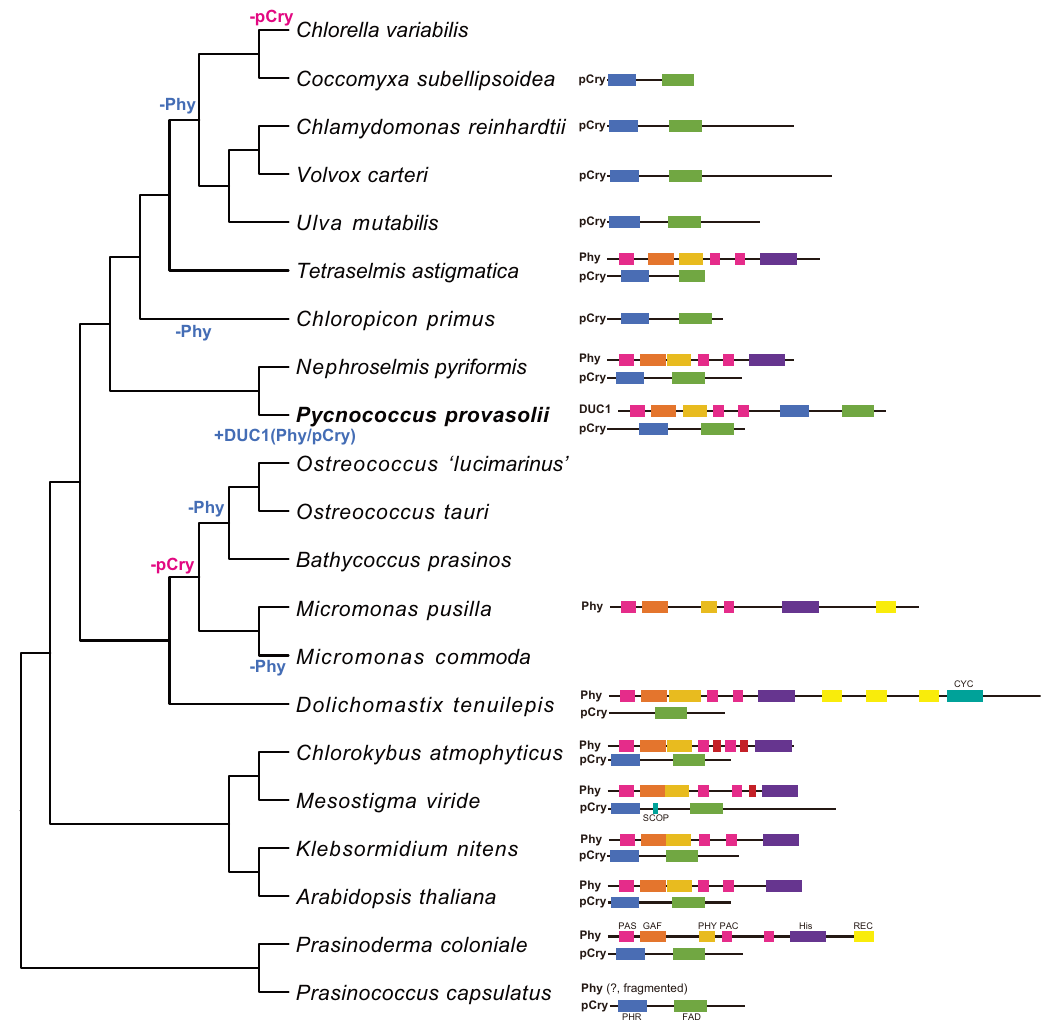
Fig. 4 Evolutionary scenario of PHY and pCRY in chlorophytes. The phylogenetic relationships of representative chlorophytes and the domain structures of their PHYs and pCRYs are shown. The tree topology is based on this study. The NCBI-nr database or MMETSP assemblies were searched for PHYs and pCRYs. Each domain is depicted by a different